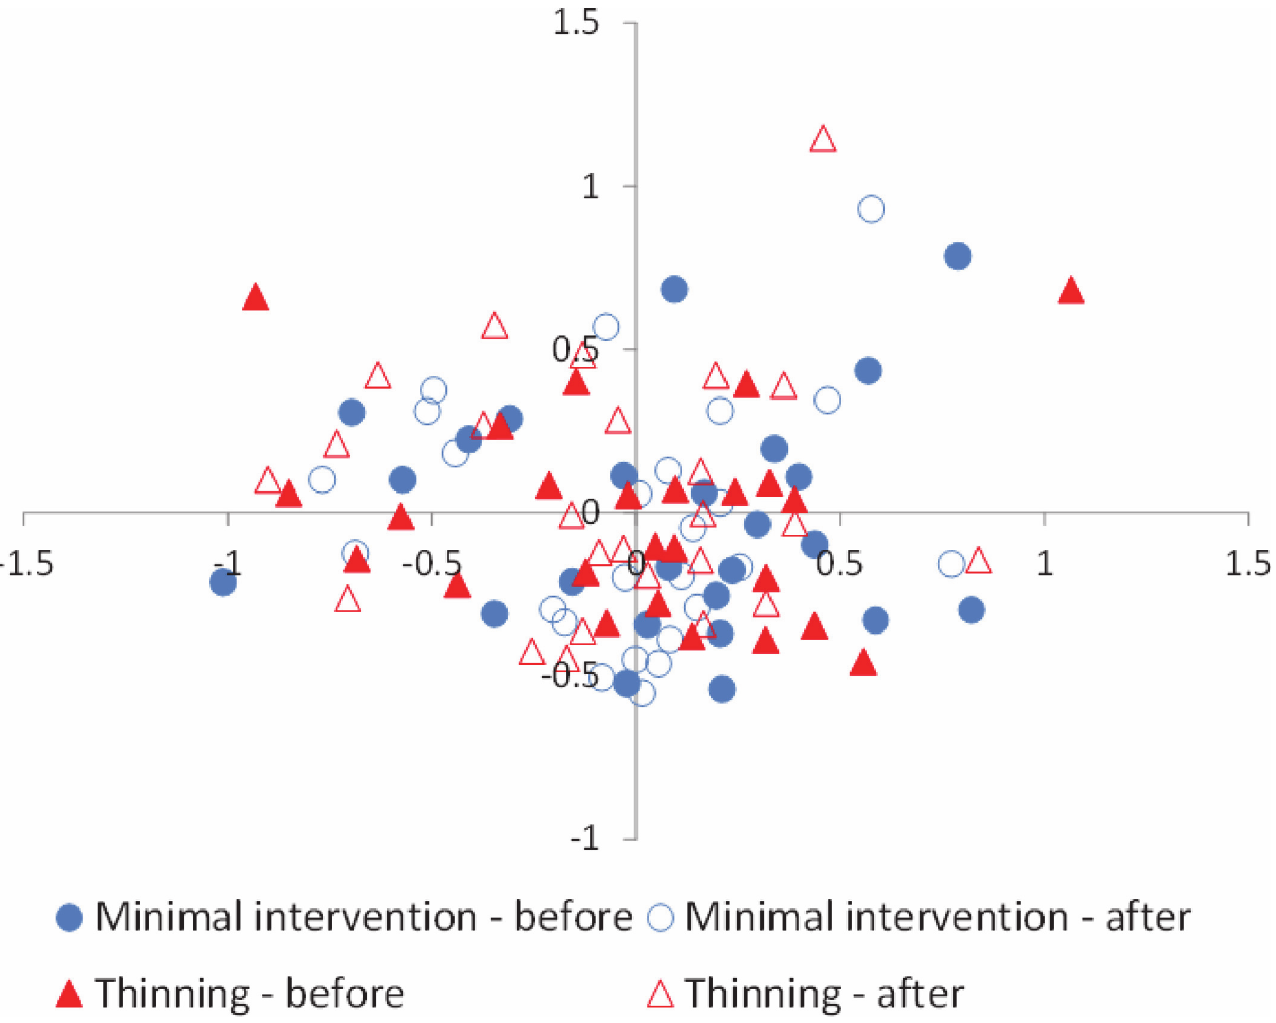
Fig 5. Variation in species composition between the plots: before-after in treatment plots (thinning) and before-after in minimal intervention plots (reference). Analysis based on a two dimensional ordination, using abundance data (NMDS, stress-value